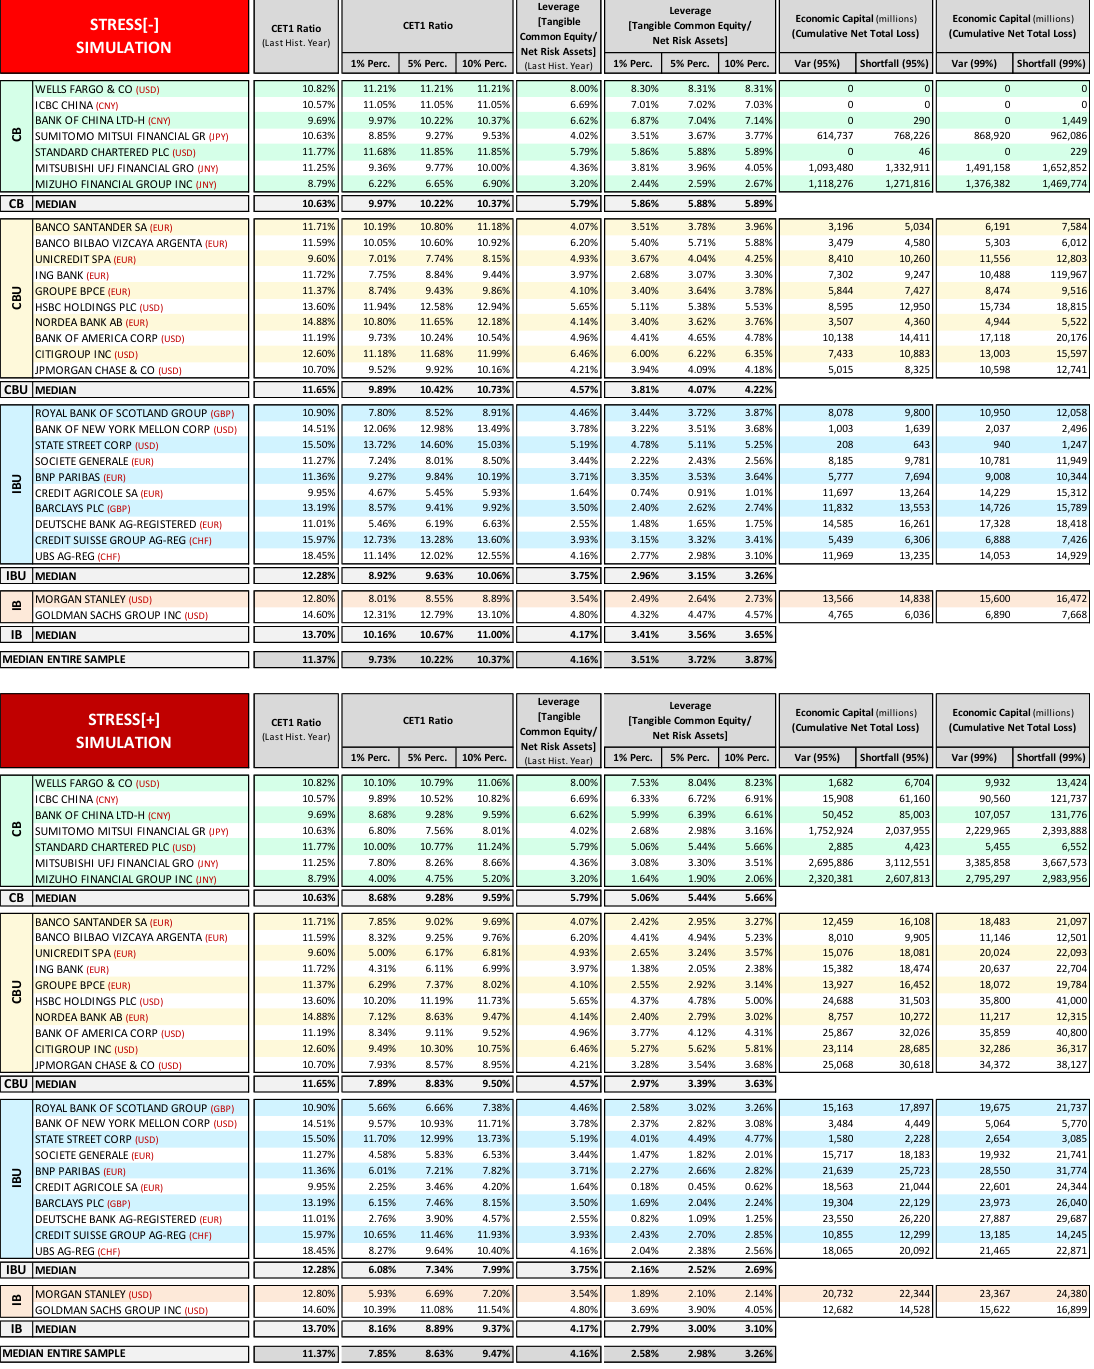
Figure A5. 2014 Stress test exercise: capital adequacy and economic capital.